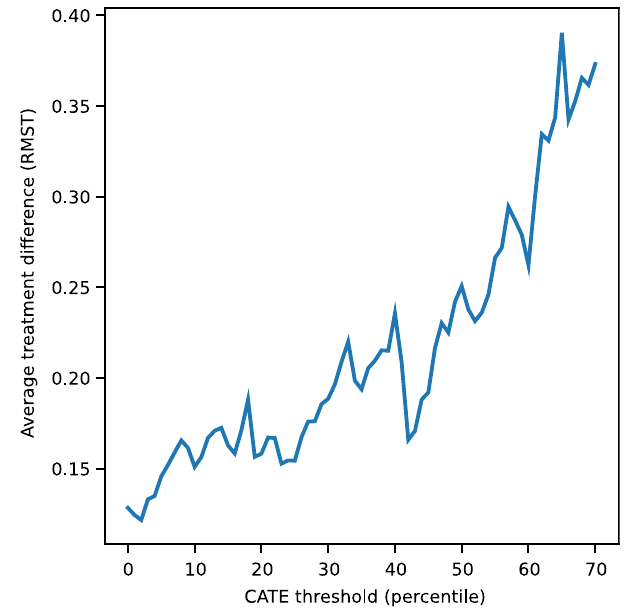
Fig. 1 | Average treatment difference curve for the anti-CD20-Abs held-out test set. Represents the difference in the ground-truth restricted mean survival time (RMST), calculated at 2 years using time-to-CDP24, between anti-CD20-Abs and placebo, among predicted responders de fi ned using various thresholds. The con- ditionalaveragetreatmenteffect(CATE)percentilethresholdistheminimumCATE (expressed as a percentile among all CATE estimates in the test set) that is used to de fi neanindividualasaresponder(i.e.athresholdof0.7meansthe30%predicted to be most responsive are considered